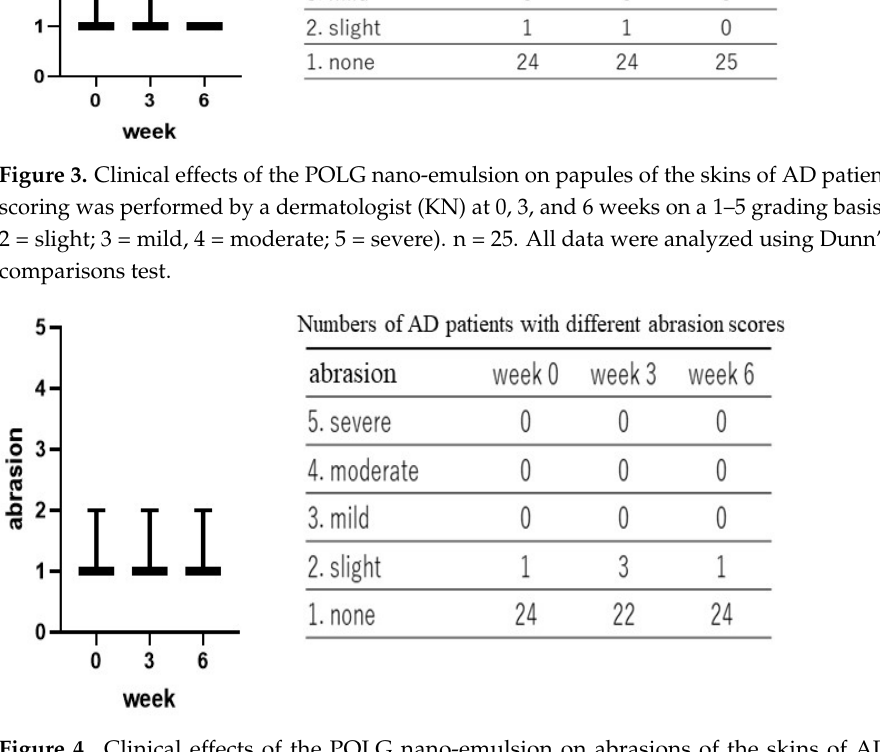
Figure 4. Clinical effects of the POLG nano-emulsion on abrasions of the skins of AD patients. Abrasion scoring was performed by a dermatologist (KN) at 0, 3, and 6 weeks on a 1–5 grading basis (1 = none; 2 = slight; 3 = mild, 4 = moderate; 5 = severe). n = 25. All data were analyzed using Dunn’s multiple comparisons test.